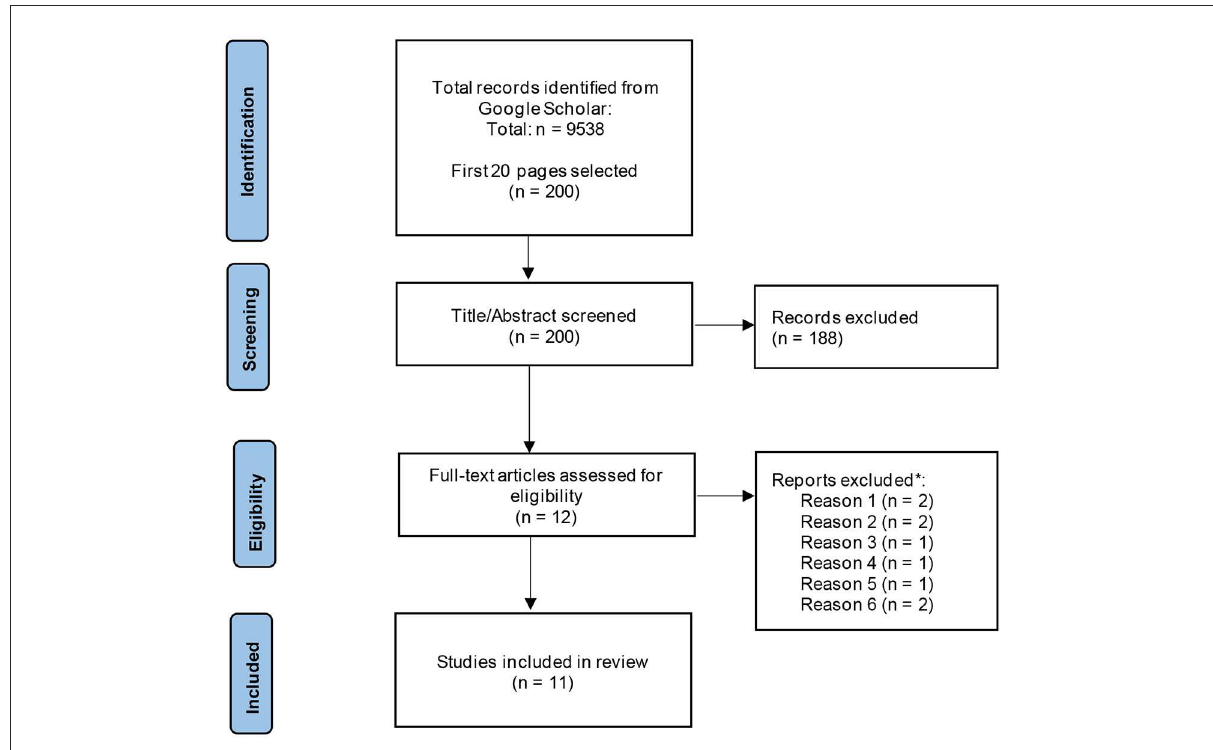
FIGURE2 PRISMA flow diagram of paper selection process from follow-up search on Google